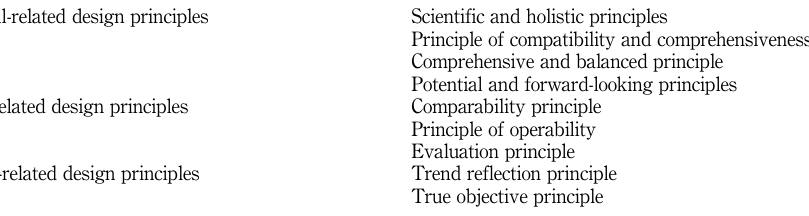
Table I. Design principles of evaluation index